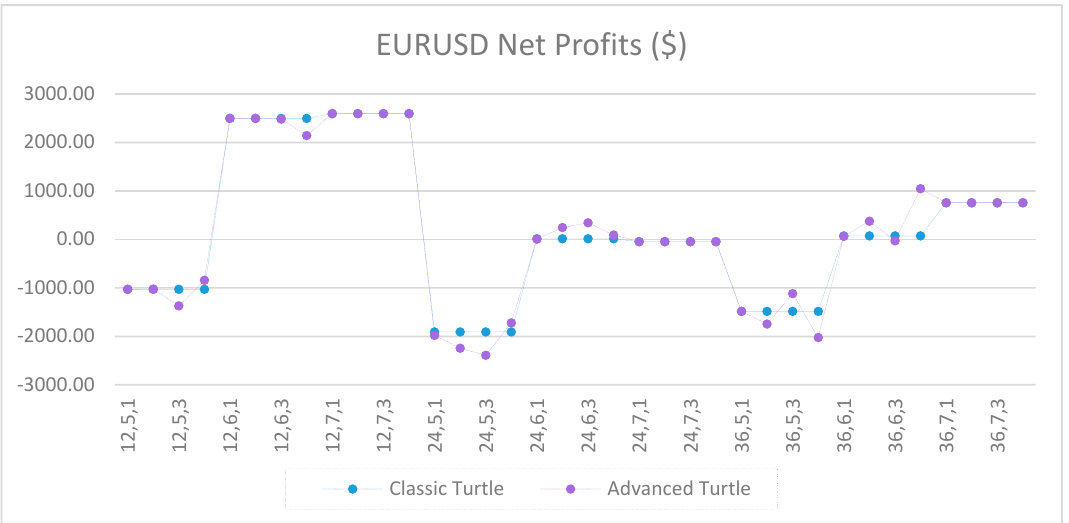
Figure A51. Net profits of EURUSD between the classic and the advanced Turtle systems for every combination of N, X, Y for the slow parameters (80, 160), where X ≥ 5.